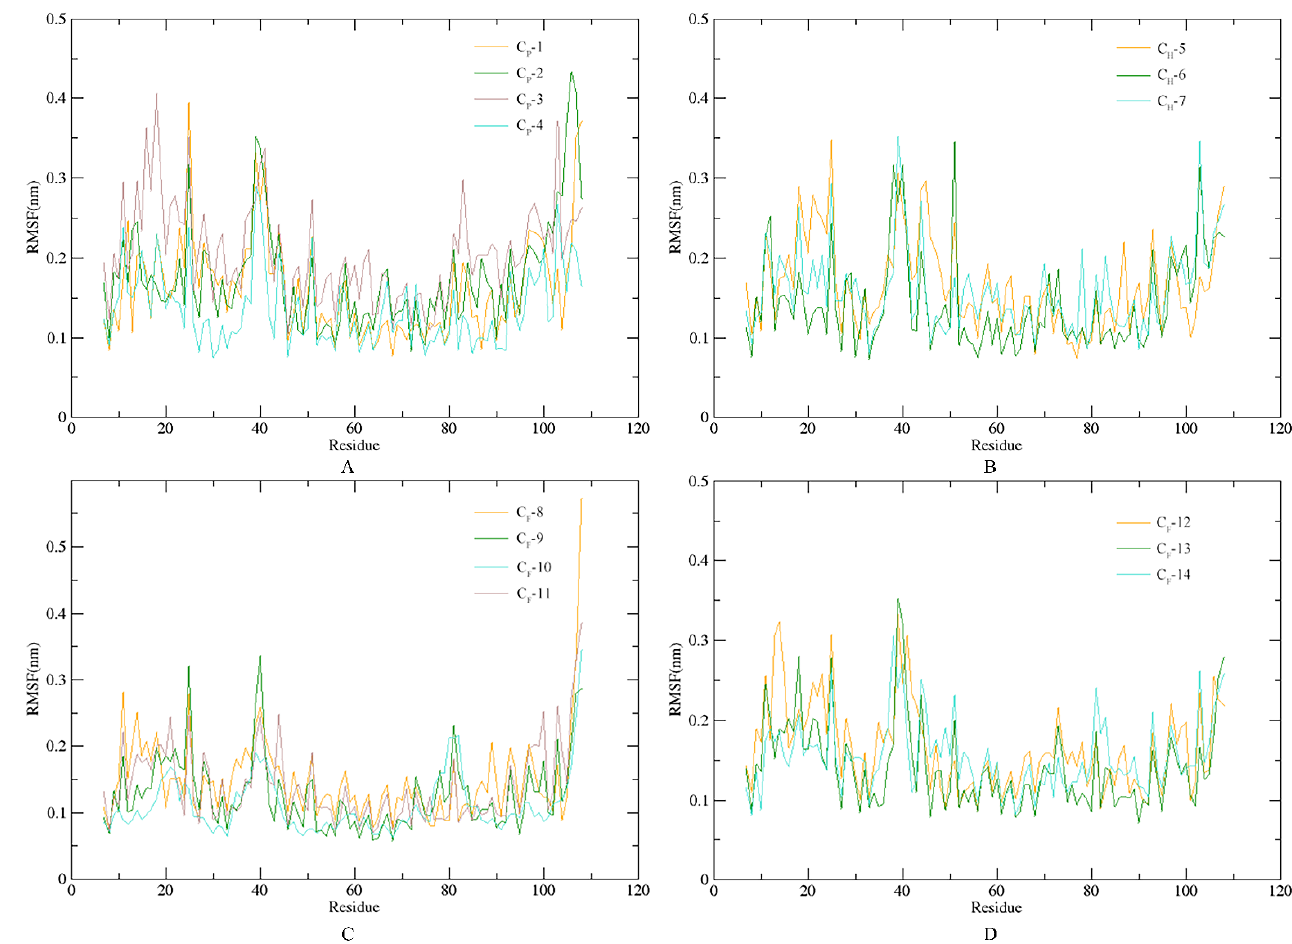
Figure 9. Residue fluctuations for SnitCSP4-ligand complexes during 40 ns MD simulations. (A) RMSF of C P -1 , C P -2 , C P- 3 , C P -4; (B) RMSF of C H -5 , C H -6 , C H -7; (C) RMSF of C F -8 , C F -9 , C F- 10 , C F -11; (D) RMSF of C F -12 , C F -13 , C F- 14 .